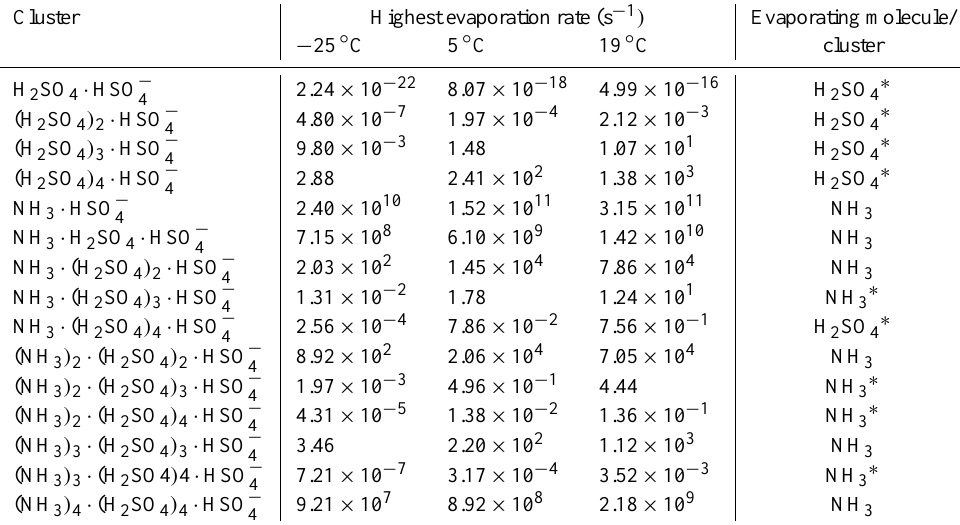
Table 1. Evaporation rates from anion clusters, used for the ACDC model simulations. Clusters that were seen in the APi-TOF spectra are shown with the ∗